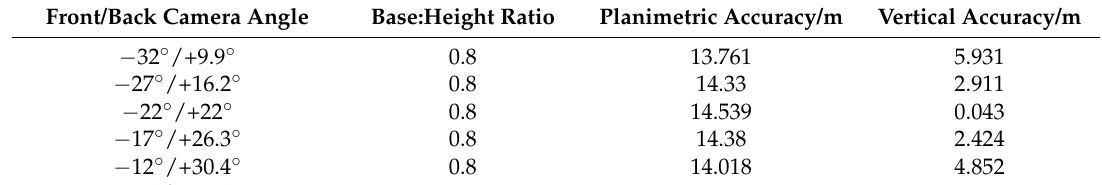
Table 4. Vertical accuracy simulation of stereo images under the same base:height ratio.